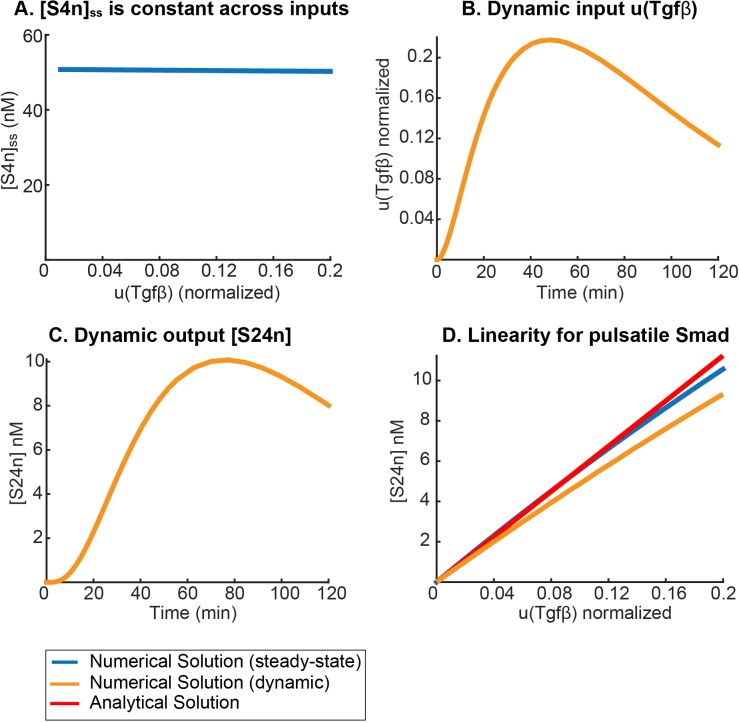
Model simulations for the Tgfβ pathway.(A) Nuclear Smad4 concentration is constant to within 2%, over a physiologically relevant range of u(Tgfβ) considered here, justifying its inclusion into parameter group α. (B–D) Numerical simulation of pulsatile response in the Tgfβ pathway. (B) A pulse of input, active Tgfβ receptor, is generated by Tgfβ addition in a model that includes details of receptor desensitization (Vizán et al., 2013). (C) S24n output also exhibits a pulsatile response. (D) We plot the peak S24n output against peak input, and find that it matches our steady-state predictions for linear input-output behavior.